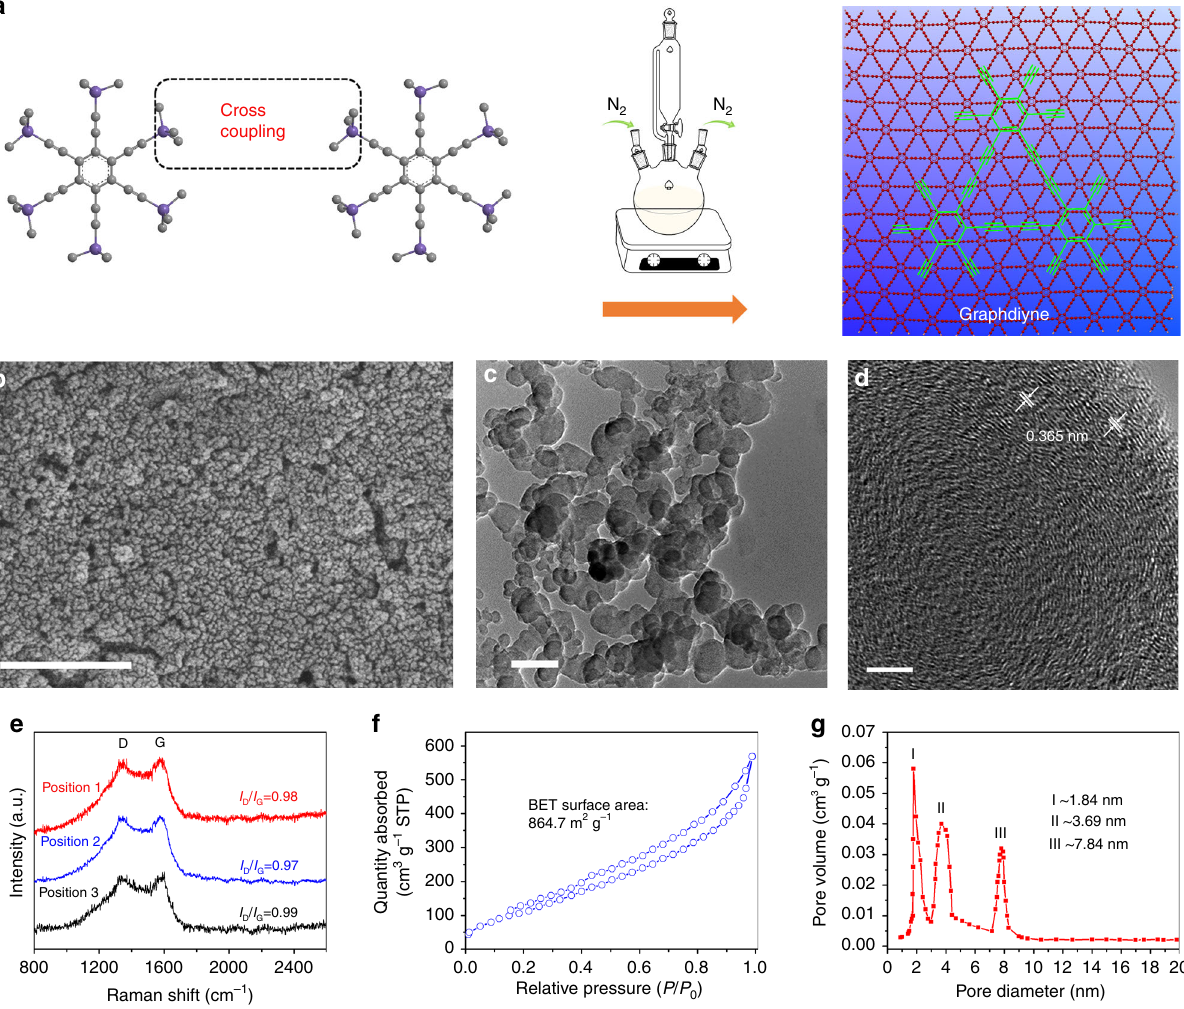
Fig. 1 Synthesis and microstructure characterizations of graphdiyne. a Schematic illustration for the synthesis of graphdiyne. b SEM image of graphdiyne, scale bar 500 nm. c TEM image of graphdiyne, scale bar 100 nm. d HRTEM images of graphdiyne, scale bar 5 nm. e Raman spectra of graphdiyne. f N 2 adsorption/desorption isotherms of graphdiyne. g Pore size distribution of